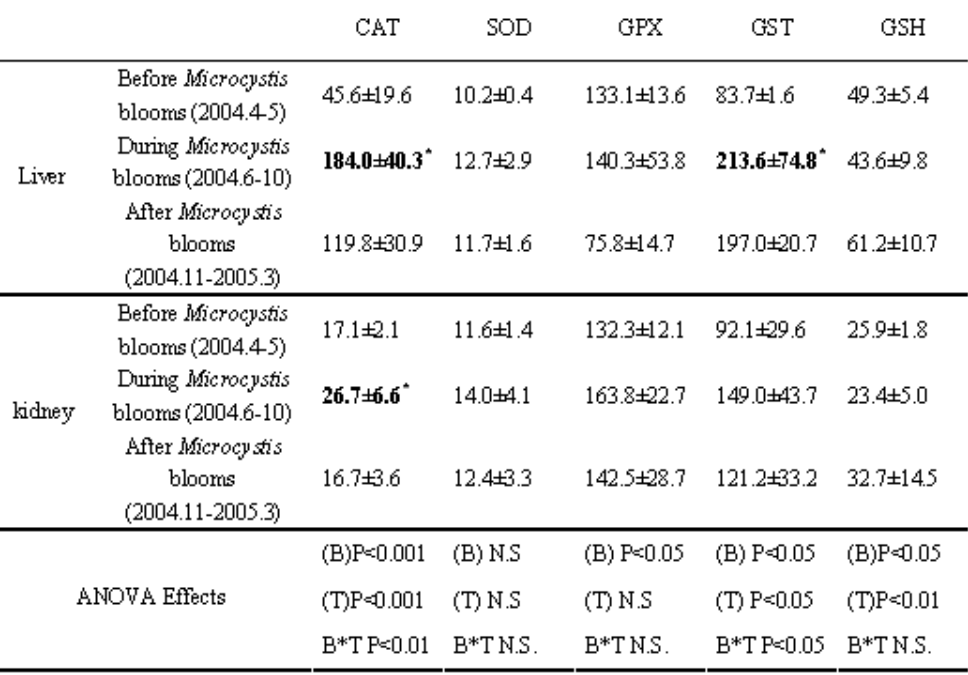
The Activities of Antioxidant Enzymes CAT, SOD, GPX, and GST and GSH Levels in the Liver and Kidney of Bighead Carp Collected from the Fish Pen in Meiliang Bay of Taihu Lake During Three Periods (Before, During, and After Microcystis